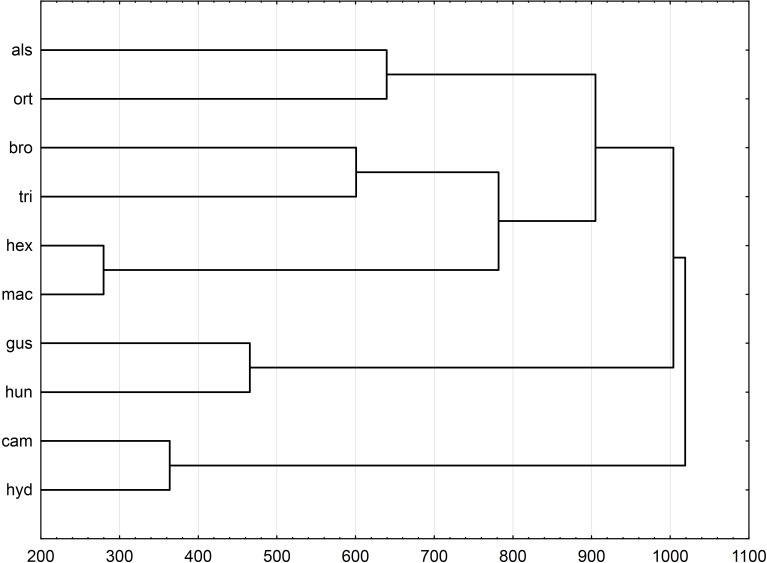
Morphological relationships of seeds among surveyed Elatine species displayed by Mahalanobis distance-based UPGMA cluster based on the following features: rectangle a, angle of curvature, and number of pits.For acronyms, see Table 1.